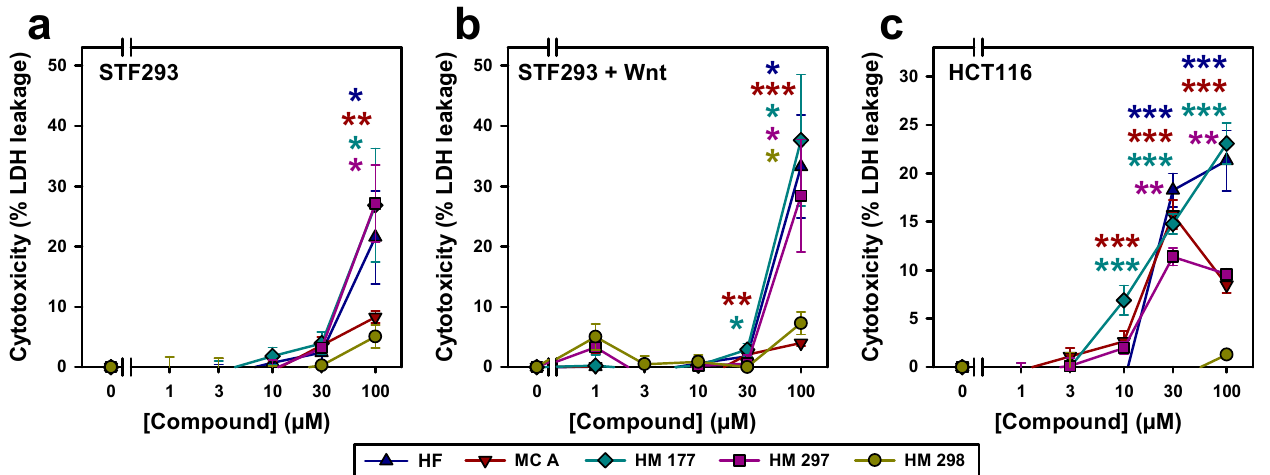
Figure 2. Cytotoxicity of HF, MC A and its derivatives HM 177, HM 297 and HM 298, as analyzed by quantification of lactate-dehydrogenase released in response to the indicated concentrations of compounds from ( a ) STF293 ( n ≥ 3; two-tailed Student’s t -test), ( b ) STF293 cells treated with Wnt3a-conditioned medium ( n = 3 for HF, MC A, HM177; n = 2 for HM 297 and HM 298; two-tailed Student’s t -test) and ( c ) HCT116 cells ( n ≥ 6; Mann–Whitney rank sum test) normalized to DMSO solvent control. Each sample was measured in duplicate. * p < 0.05 ** p < 0.01; *** p < 0.001. In complementary fluorescein diacetate (FDA) viability assays quantifying metabol- ically active cells, concentrations up to 3 μ M of HF, MC A, HM 177 and HM 297 did not show major reduction in cell viability in STF293 cells. HF, MC A and HM 177 affected viability at 10 μ M, whereas HM 297 affected viability at 30 μ M. HM 298 did not exhibit any effects up to 100 μ M (Figure 3a). Similar results were obtained for STF293 after Wnt3a stimulation (Figure 3b). In HCT116 cells, HF and HM 177 significantly impaired viability at a concentration of 10 μ M. This effect appears to be not as strong as in STF293 cells. MC A and HM 297 attenuated viability at 30 μ M and higher concentration. As for STF293 cells, HM 298 showed no effect on HCT116 viability (Figure 3c).